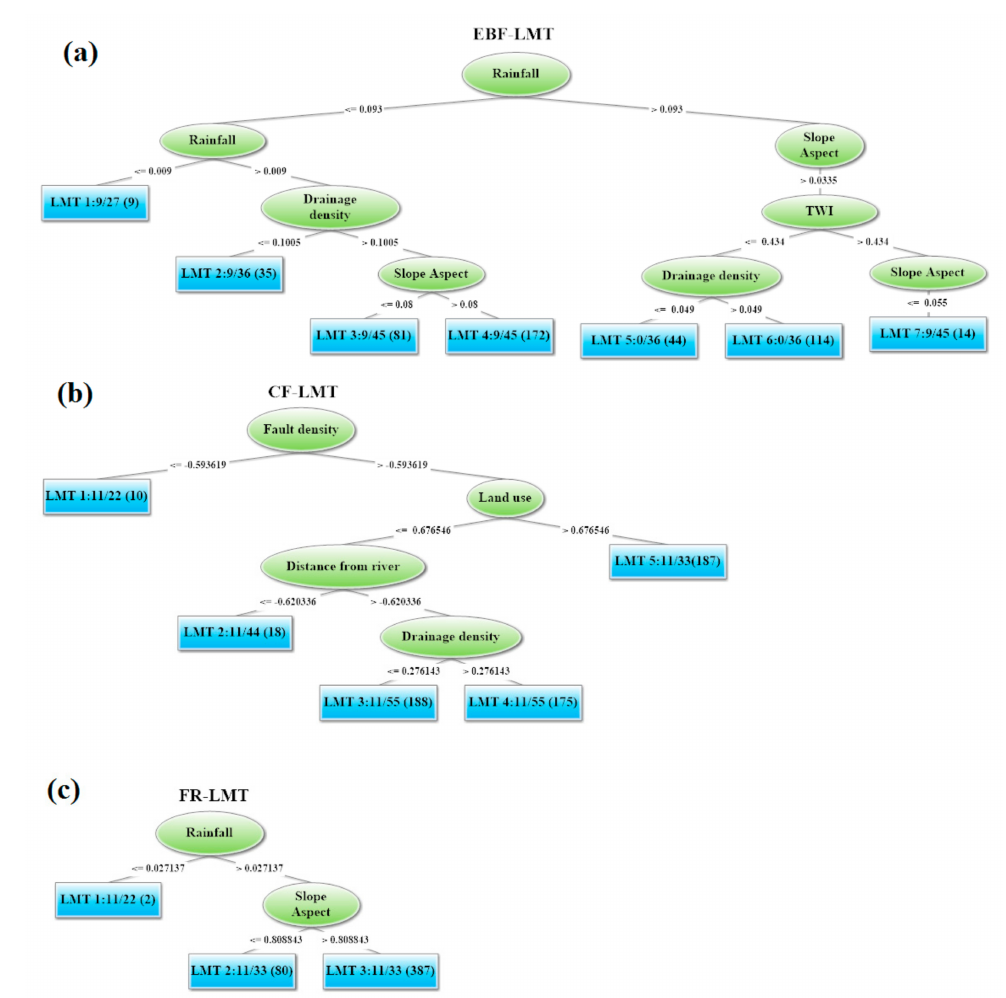
Figure 4. The relative importance of the factors using the random forest (RF) model.